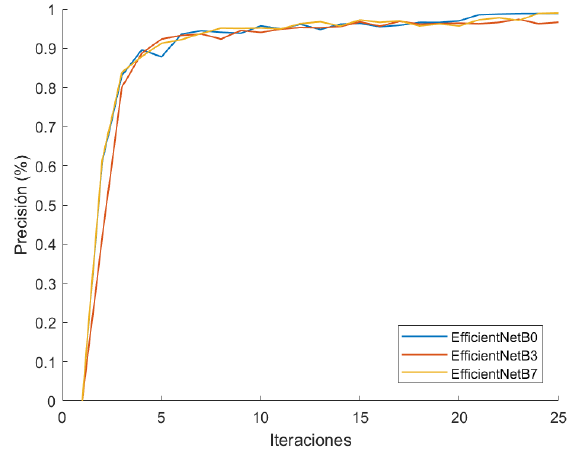
Figure 17. EfficientNet B0-B3-B7 comparison in VeRi-776 training.